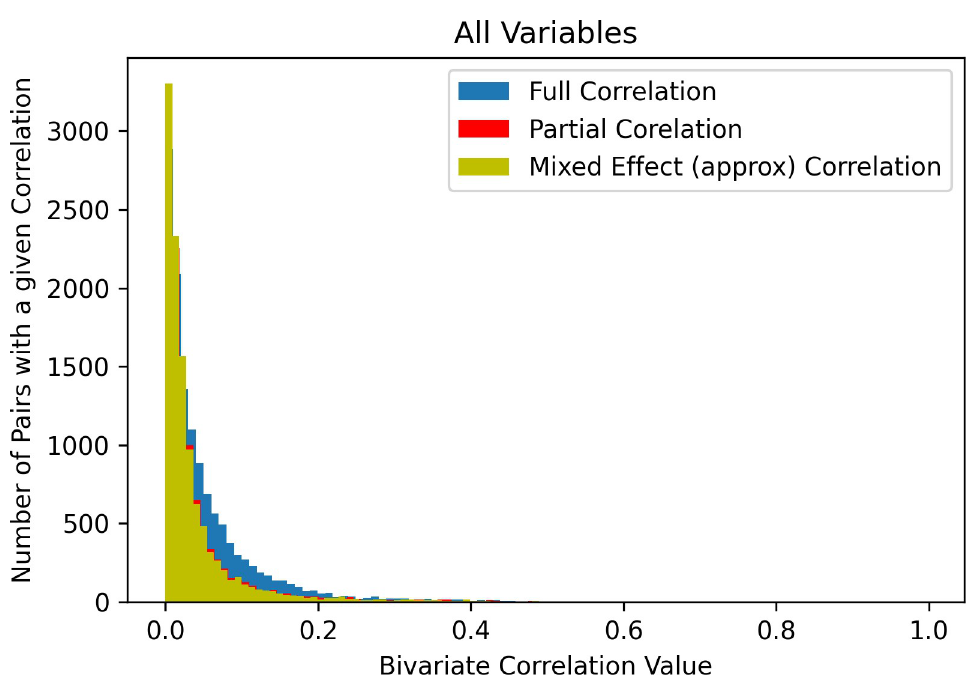
Fig 2. In yellow: Distribution of correlations from mixed effect modeling controlling for age, sex, race, parent income, parent education, parent marital status, site (as a random effect), and family id (as a random effect). In red: partial correlations controlling for age, sex, race, parent income, parent education, parent marital status, and site (in red). In blue: bivariate Pearson correlations.